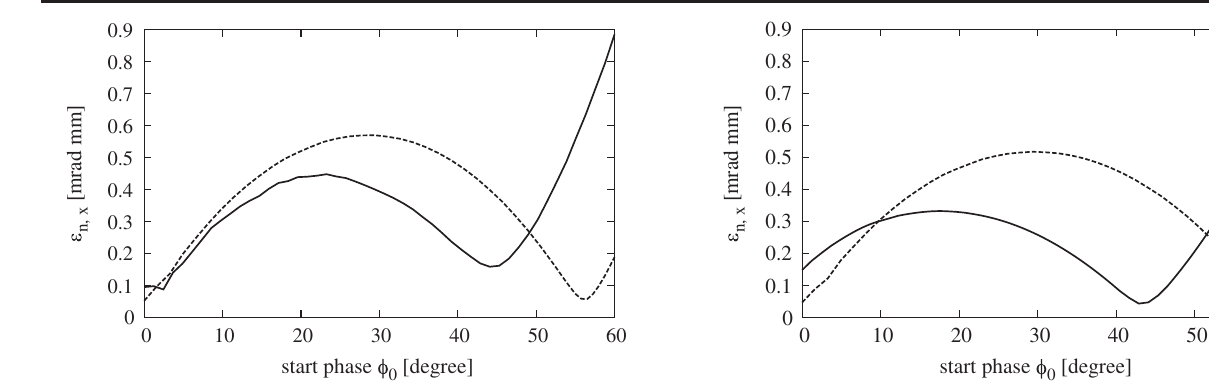
FIG. 16. Compensation of the rf-induced emittance by a cavity FIG. 18. Compensation of the rf-induced emittance in a two running at the fundamental frequency. The setup consists frequency cavity. The setup consists of a half-cell rf gun cavity ¼ 0 . 0 mm, σ ¼ 0 . 75 mm, of a half-cell rf gun cavity (1.3 GHz, E 0 ¼ 50 MV = m, (1.3 GHz, E 0 ¼ 50 MV = m, x x off x ¼ 0 . 0 mm, σ ¼ 0 . 75 mm, ϕ ¼ 4 . 68 °), 5 cm drift, and a ϕ ¼ 4 . 68 °), which simultaneously supports the third harmonic x m m off single-cell cavity (1.3 GHz, E 0 ¼ 50 MV = m) running at the periods) at 5 . 2 MV = m. The third harmonic frequency ( 1 1 2 fundamental frequency. The phase of the single-cell cavity is frequency is operated at a start phase of 134°. The lines show fixed to 48° off crest for a start phase in the gun cavity of 45°. the emittance at the exit of the cavity without (dashed line) and With this phase only the linear part of the rf-induced emittance is with the higher frequency rf field (solid line). compensated, while the quadratic part is increased. The lines show the emittance at the entrance (dashed line) and at the exit (solid line) of the single-cell cavity.